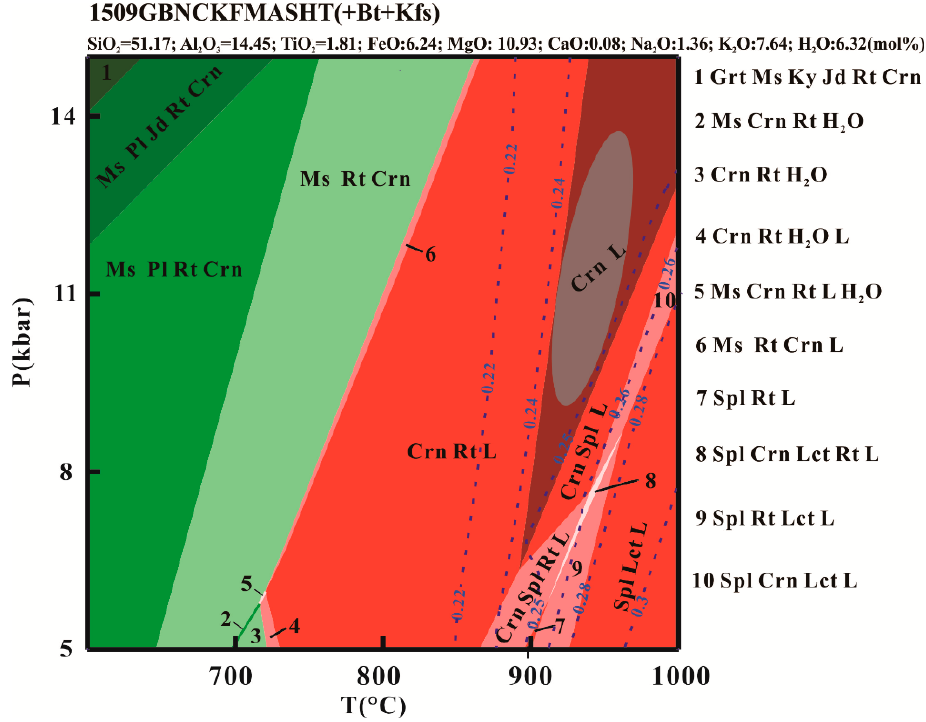
Figure 7. Calculated P-T pseudosections for sample 1509GB. Melt-bearing fields are red, melt absent fields are green. Isopleths of biotite X Ti proportion (in mol%) are reported as blue dotted lines; Gray oval corresponds to the estimated peak condition.